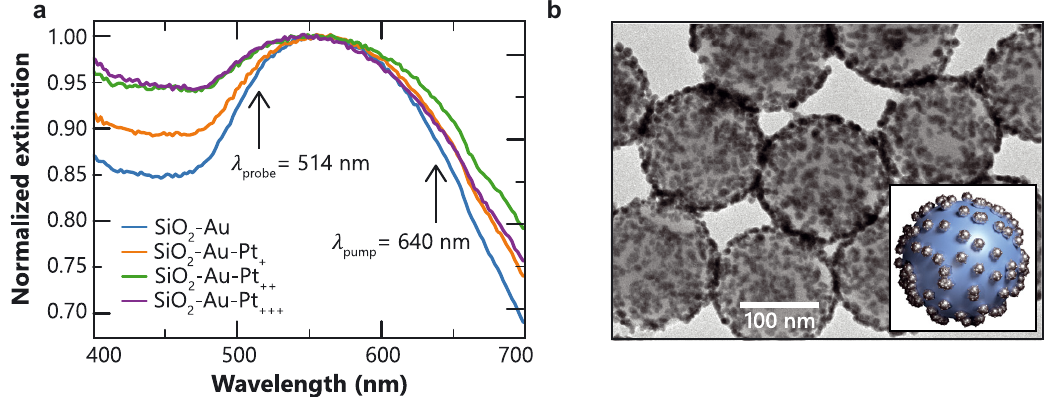
–Au–Pt hetero-nanoparticles. (a) Normalized extinction spectra of the aqueous solution Figure 1: Morphology and optical properties of SiO 2 –Au and SiO –Au–Pt nanoparticles with varying concentration of Pt (see Nanoparticle fabrication section for the nanoparticle of SiO 2 2 nomenclature). (b) TEM image of SiO –Au–Pt nanoparticles. Inset shows an artistic representation of the structure of a composite 2 nanoparticle. See Refs [19, 20] for the details of the structural